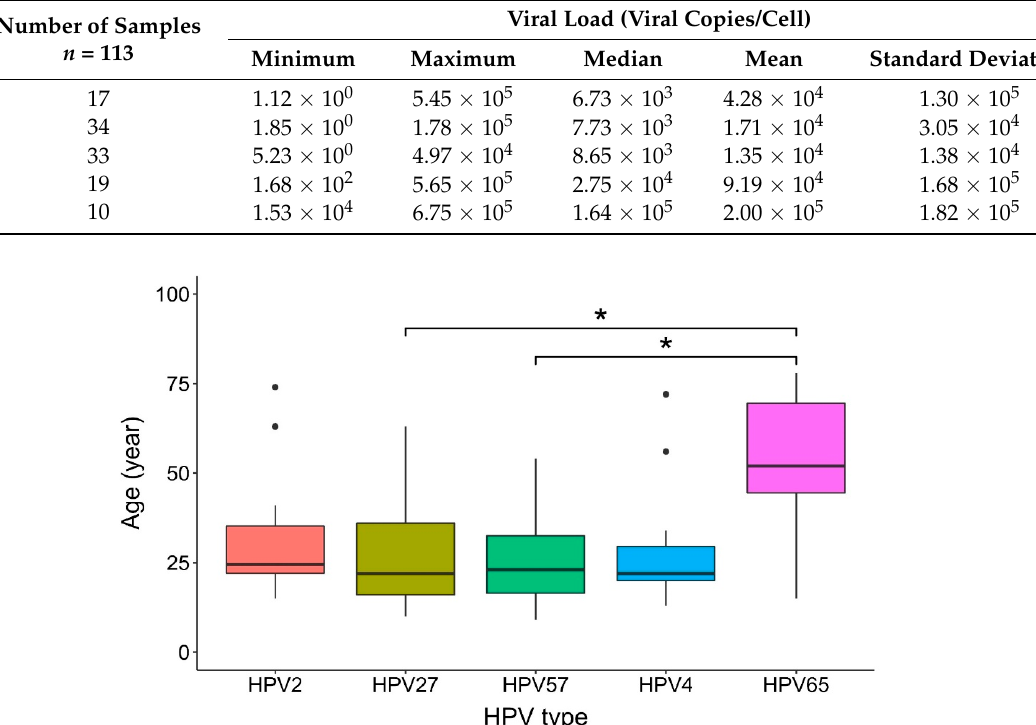
Figure 4. Comparison of patients’ age among the five most frequent causative human papillomavirus (HPV) types in common warts. HPV65 was more frequently etiologically associated with the development of common warts in significantly older patients (median age: 52 years) than HPV27 (median age: 22 years; *, p = 0.047) and HPV57 (median age: 23 years; *, p = 0.047). Statistical com- parison was performed with the Kruskal–Wallis test and considered that three patients with multi- ple samples of common warts had different causative HPV types in different warts.